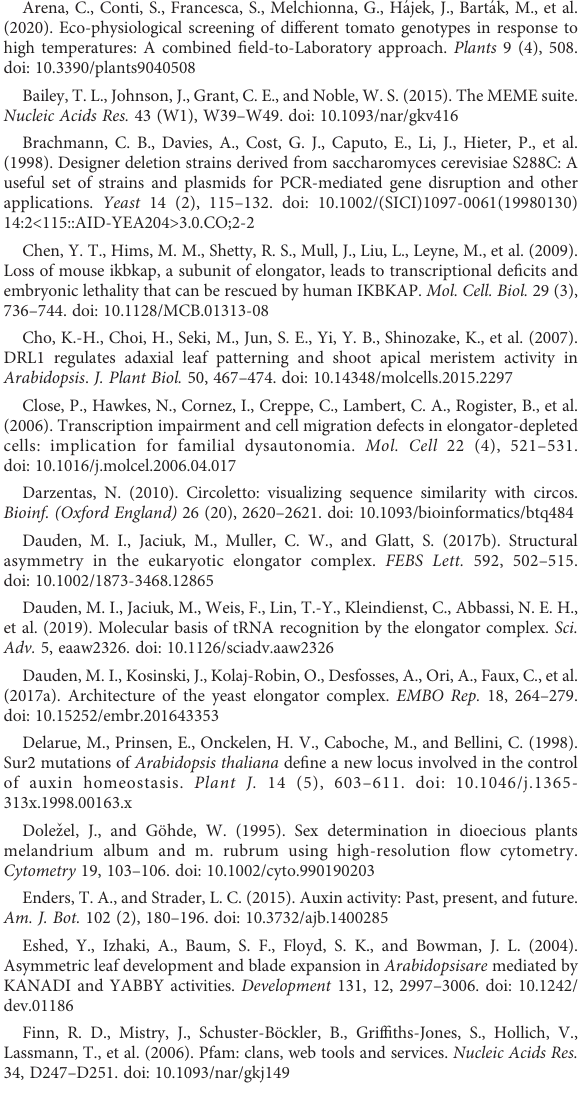
SUPPLEMENTARY FIGURE 1 Expression level of AtELP4 and ScELP4 in yeast wild type (BY4741), elp4 D mutant (Y02150), three lines of pTU1-empty vector harboring elp4 D mutant (#1, #5, and #8), and two lines of pTU1-AtELP4 harboring elp4 D mutant (#2 and #29) by (A) semi qRT-PCR and (B) qRT-PCR. To con fi rm ELP4 silence of Y02150, the expression level of endogenous Saccharomyces cerevisiae ELP4